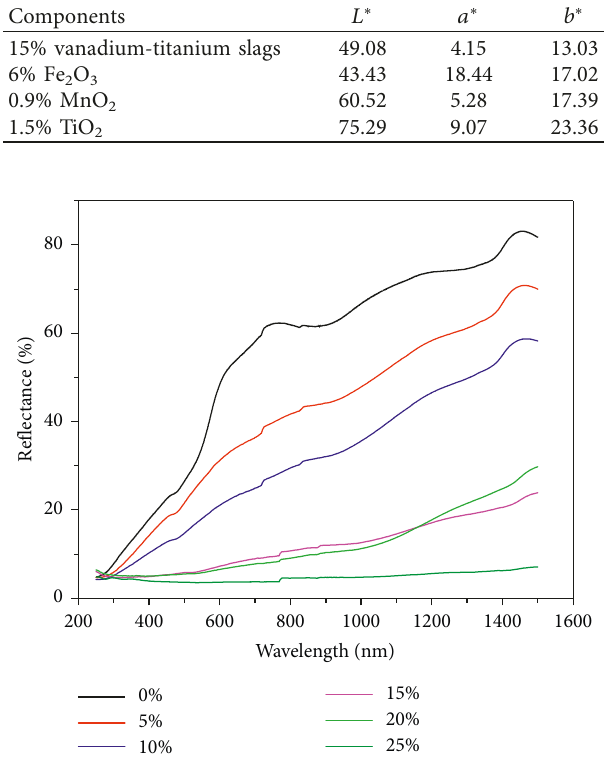
Figure 5: Reflectance spectra of ceramics with different vanadium- titanium slags.